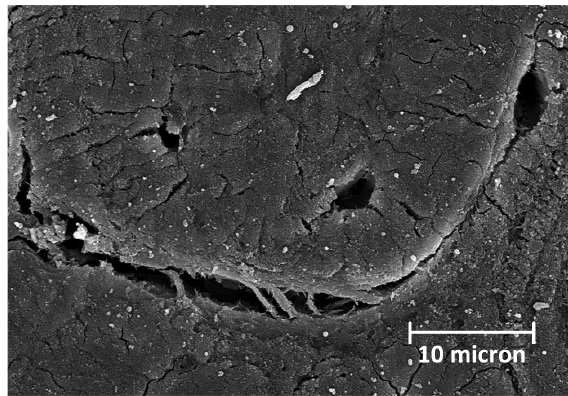
Figure 4: A deflected crack in the interstitial bone of the middle region of the loaded cortical bone.